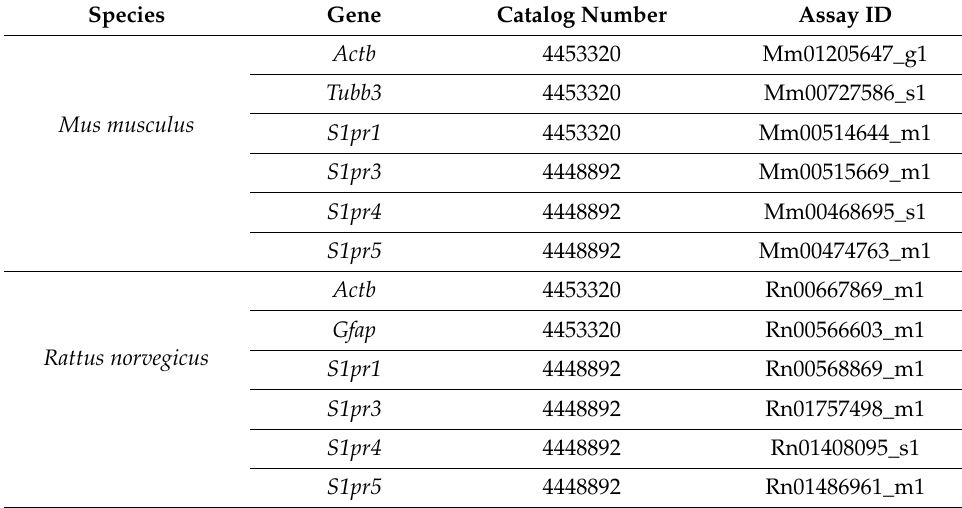
Table 7. TaqMan Assays used for